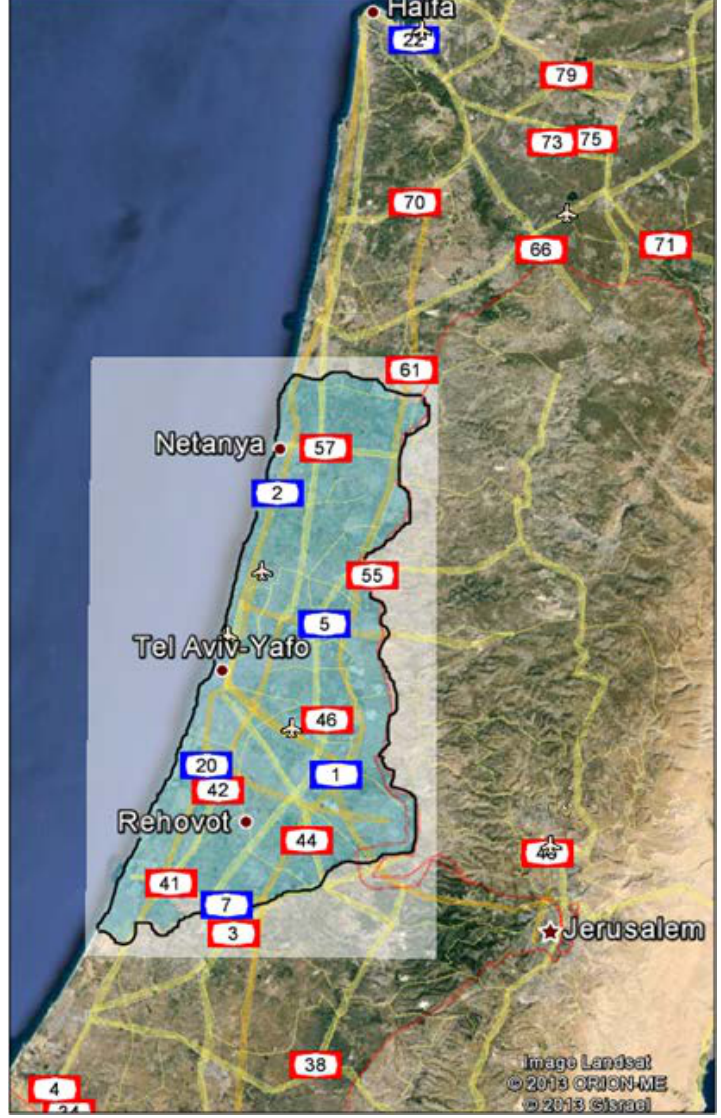
Figure 1. Tel Aviv Metropolitan